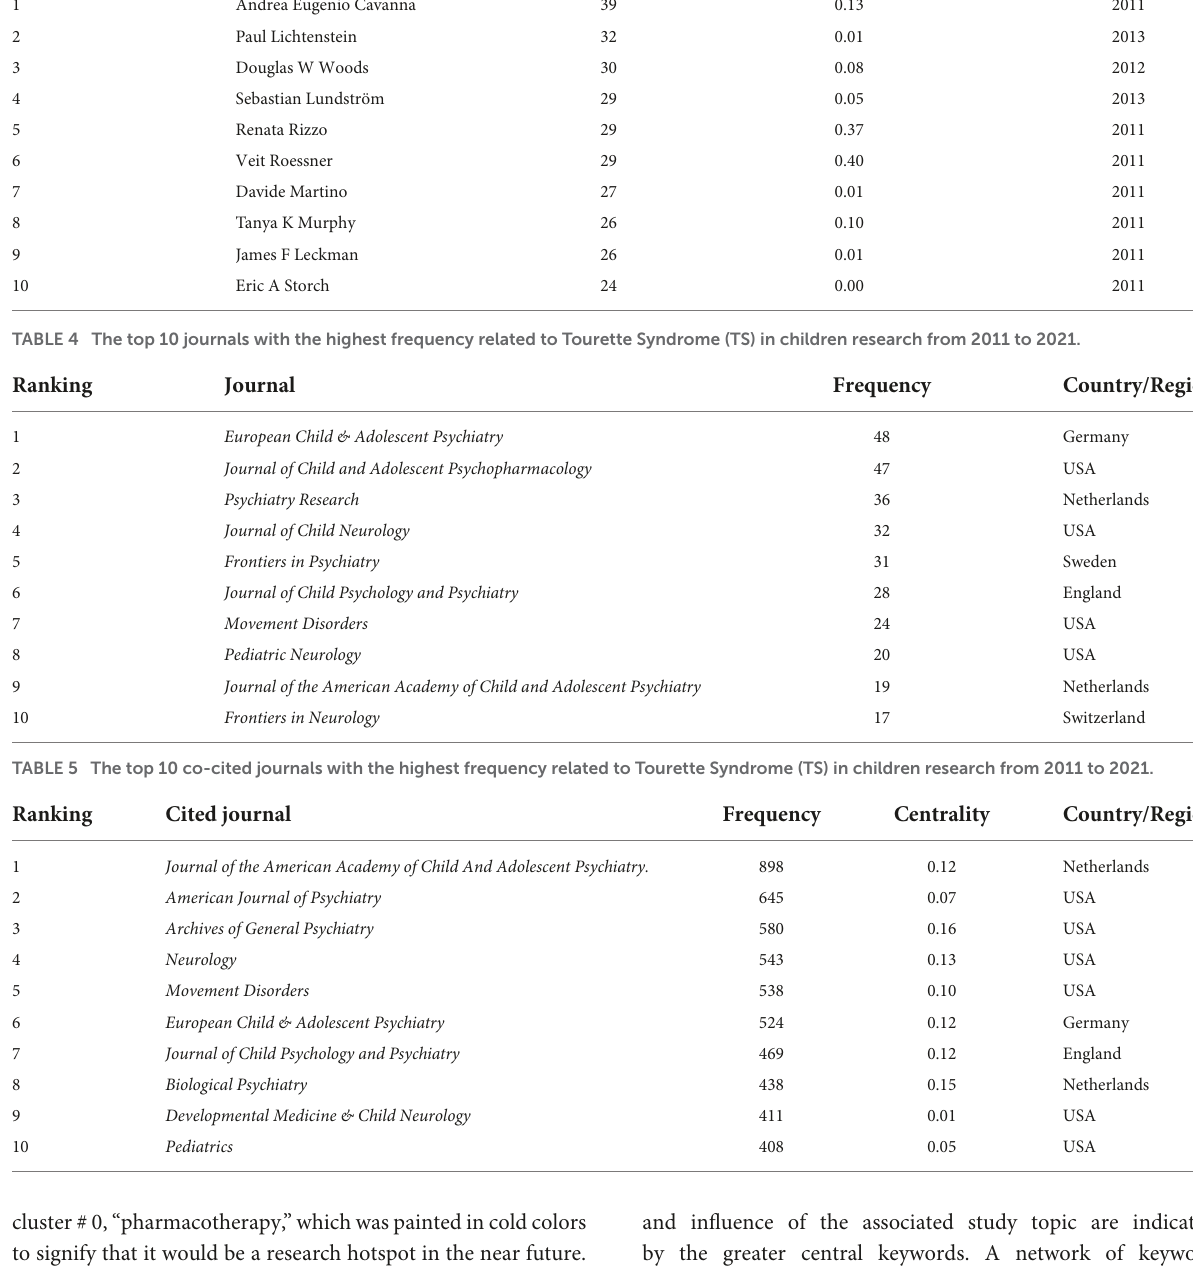
TABLE 3 The top 10 authors related to Tourette Syndrome (TS) in children research from 2011 to 2021. Ranking